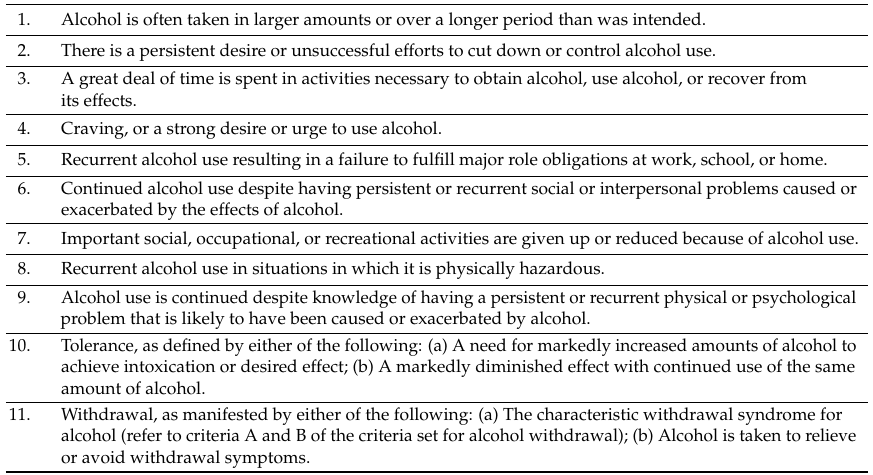
Table 1. The fifth edition of Diagnostic and Statistical Manual of Mental Disorders (DSM-5) criteria for the framing of patients with alcohol use disorder